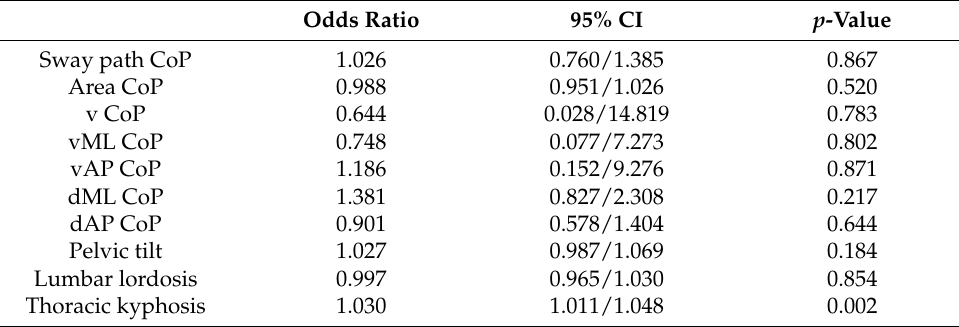
Table 5. Manifestation of back pain against balance and posture